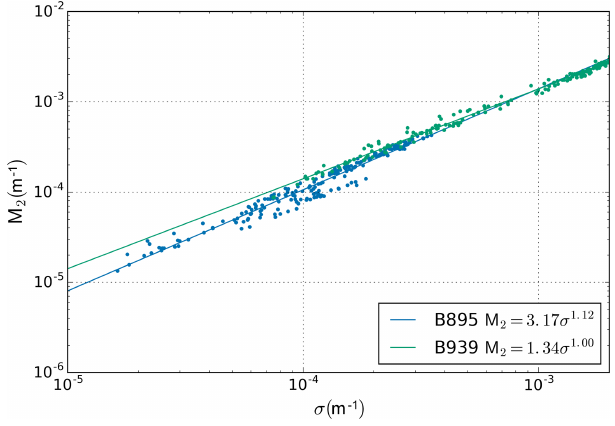
Figure 6. Extinction /M 2 relations determined from in situ mea-